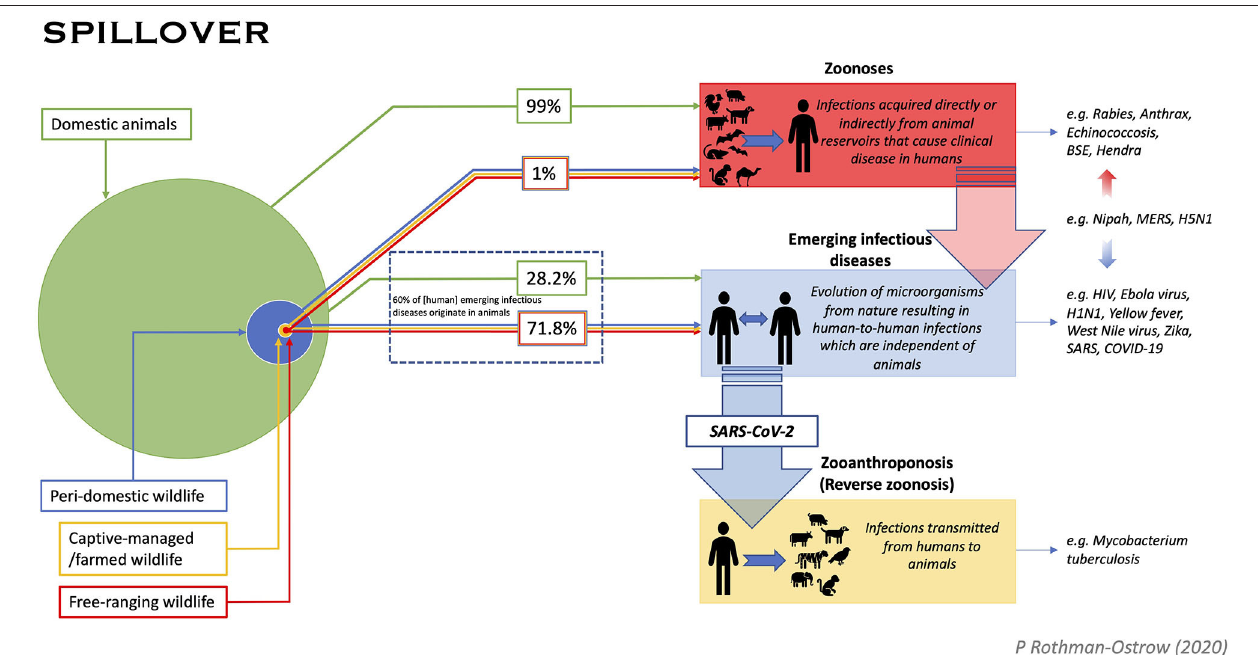
FIGURE 1 | Pathway diagram for pathogen spill-over to humans from animals describes three distinct processes. (1) Zoonoses: Pathogens that are transmitted from an animal reservoir directly or indirectly (e.g., foodborne, vector-borne, etc.) to humans causing disease; (2) Emerging Infectious Diseases: Pathogens that cause an emergent infectious disease in humans and persist in human populations irrespective of an animal reservoir. Genetic origins may show links to non-human animals, but these diseases undergo a more complex process of evolution not necessarily dependent on a specific animal reservoir, and usually evolve to be independent of animals, (3) Zooanthroponosis: “Reverse zoonosis” whereby humans transmit infection to animals. Infected animals, may or may not then go on to circulate the pathogen or establish a disease within conspecific population. A disease can fall into more than one category as exemplified in the figure by Nipah, MERS, and SARS-CoV-2. Spill-over origin for zoonoses and emerging pathogens (i.e., animals) is given proportion by the size of the circles. The relative infection frequency of spill-over from domestic animals and wildlife is quantified in the percentages shown. Proportion of animals was determined from a review of the literature which found that only 4% of global mammalian biomass is wild, of which > 50% is estimated to be marine mammals, with livestock making up ∼ 60% of the remainder ( 39). Percent of emerging pathogens coming from wildlife was derived from the assessment that ∼ 60% of EIDs are zoonotic, with 71.8% of those found to have wildlife genetic origins ( 6). Percent zoonoses derived from domestic vs. wild species is a rough estimate based on available data from a variety of publications and considers the following: zoonoses have been estimated to cause 2.5 billion cases of human illness, 2.4 billion of which are caused by thirteen diseases, all of which bear relevance to agriculture ( 40); zoonotic viral richness is strongly correlated with mammalian species diversity and abundance with domestic species found to harbor, on average, 19.3 zoonotic viruses compared to an average of 0.23 harbored by wildlife, suggesting wildlife harbor > 0.5% of viral diversity (43). In addition, an analysis of mammalian species with the greatest number of viruses shared with humans found the top eight species to be domestic (43). Our estimate that 99% of zoonotic diseases spill over from domestic animals is considered reliable for direct zoonotic transmission and indirect foodborne infection, though less reliable for vector borne